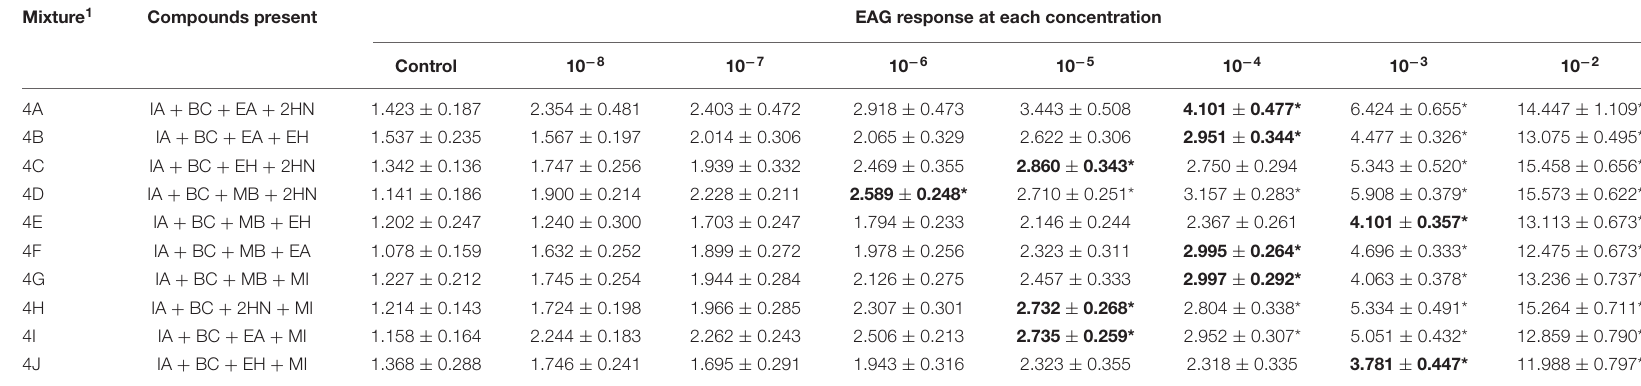
1 Mixture code used in the text for better clarification of mixture identity. The number signifies the number of compounds in the mixture and the letter identifies the mixture. IA, isoamyl acetate; BC, β -cyclocitral; MB, methyl butyrate; 2HN, 2-heptanone; MI, methyl isovalerate; EA, ethyl acetate; EH, ethyl hexanoate; BA, butyl acetate; HA, hexyl acetate. Asterisk indicates significant difference from control within row (P < 0.05). Bold values indicate the threshold dose for that mixture, i.e., where the threshold dose is the lowest concentration of a blend that induces a response significantly different from the control